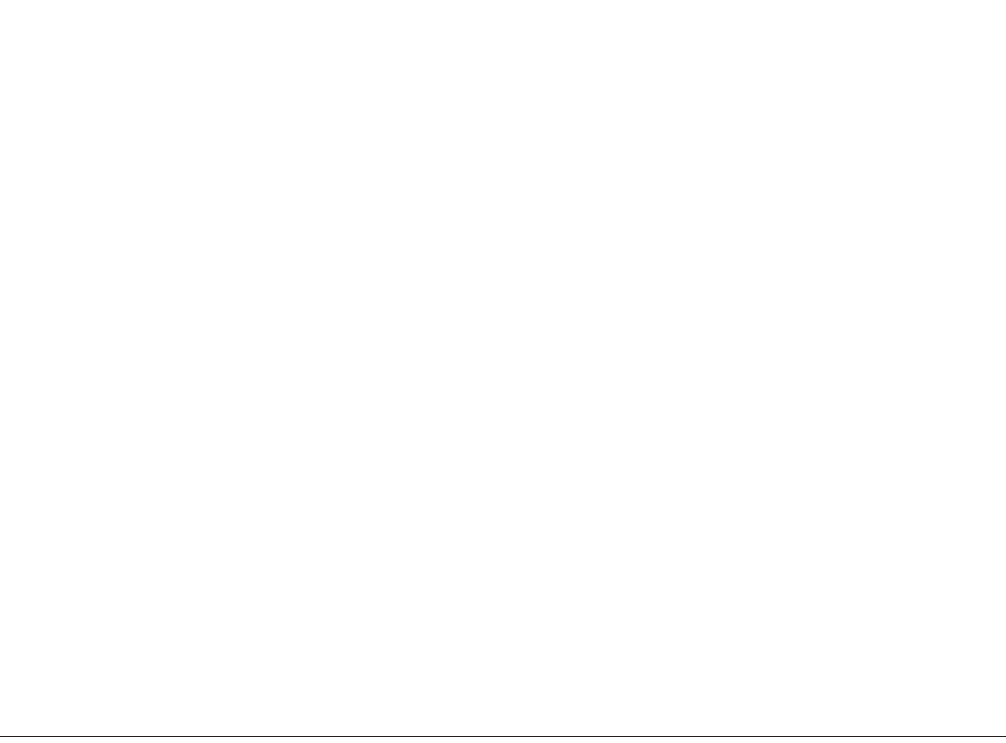
FIGURE A1 | Trajectories of the structural covariance networks derived from contralateral seeds. The plots of voxel counts by group ( P < 0 . 05, FWE) indicate a similar pattern to the ipsilateral seed, except for the auditory and speech networks, which show differences in their spatial extents. The y-axis represents the voxel number ( × 10 4